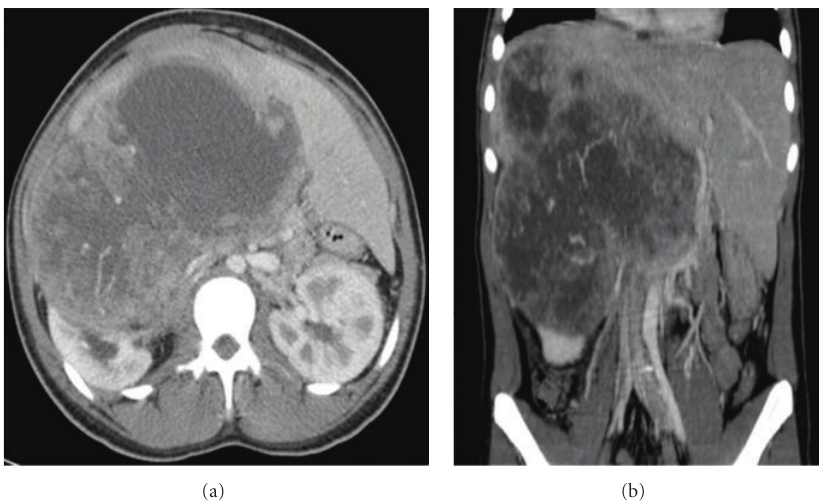
Figure 1: Preoperative CT scan showing a large, solid mass in the liver.